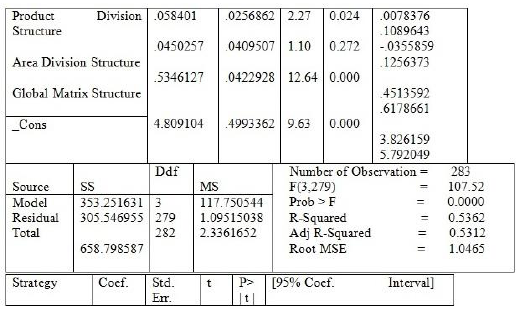
Table 1: Regress Strategy Product Division Structure Area Division Structure Global Matrix